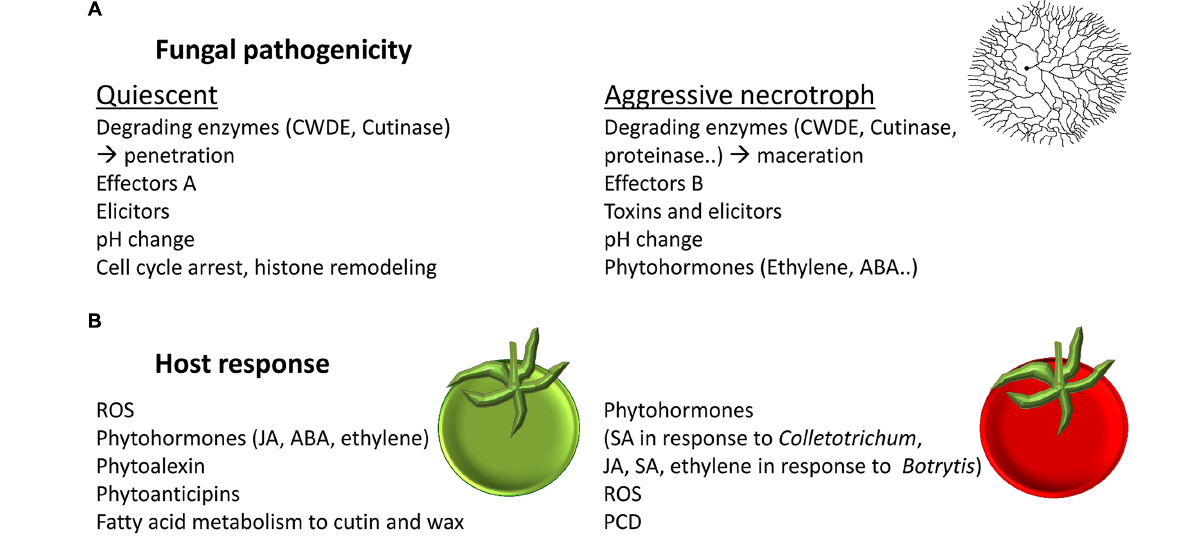
FIGURE 3 | Fungal pathogenicity and host response at different stages of fruit maturity. (A) Fungal pathogenicity factors during quiescent and during aggressive necrotrophic stage. (B) Host response to fungal colonization in unripe and in ripe